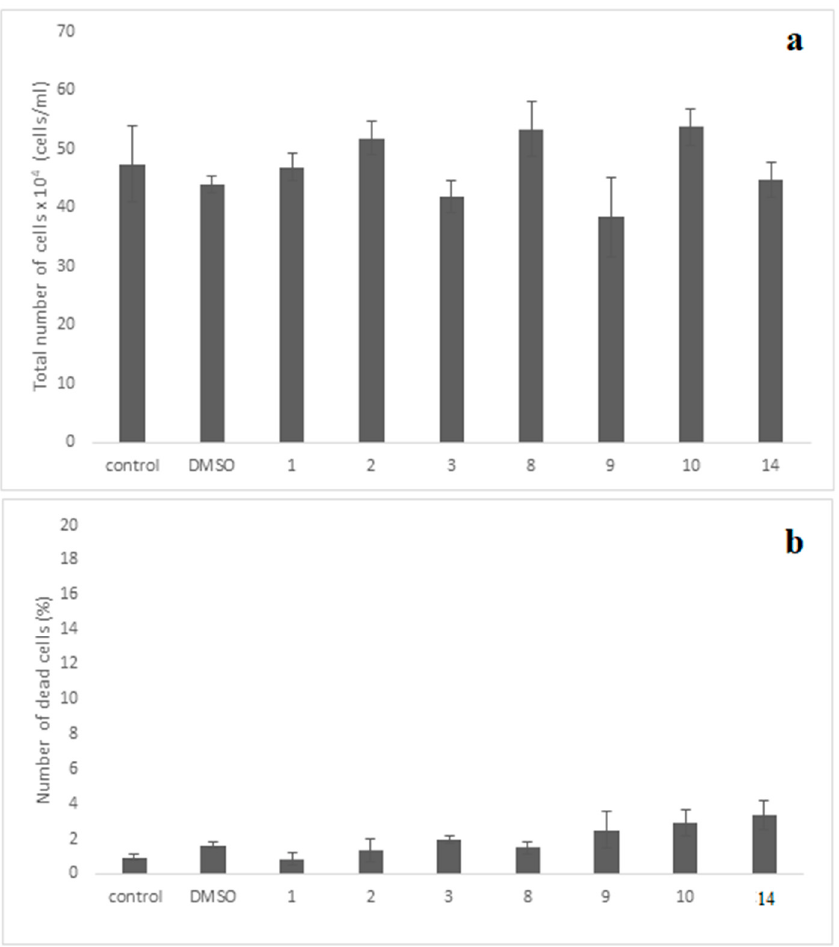
Figure 10. Assessment cell growth ( a ) and cell death ( b ) of MRC-5 cells exposed to various compounds. The MRC-5 cell cultures were incubated separately with each of the compounds at 10 − 5 M (10 µ M) for 48 h. The cell growth was determined by measuring the cell number in cultures under the microscope using the Neubauer counting chamber, as described in the “Materials and Methods”. Moreover, the dead cells accumulated in these cultures were also evaluated using the Trypan-blue exclusion-dye method, as presented in “Materials and Methods”. The results shown above indicate the mean numbers ± SD of two independent biological experiments. The diagrams shown above and the t-test statistical analysis were carried out using the GraphPad Prism 6.0 program. Notably, no statistical significance between the control-untreated culture with each one of compounds-treated cultures is seen ( p values >